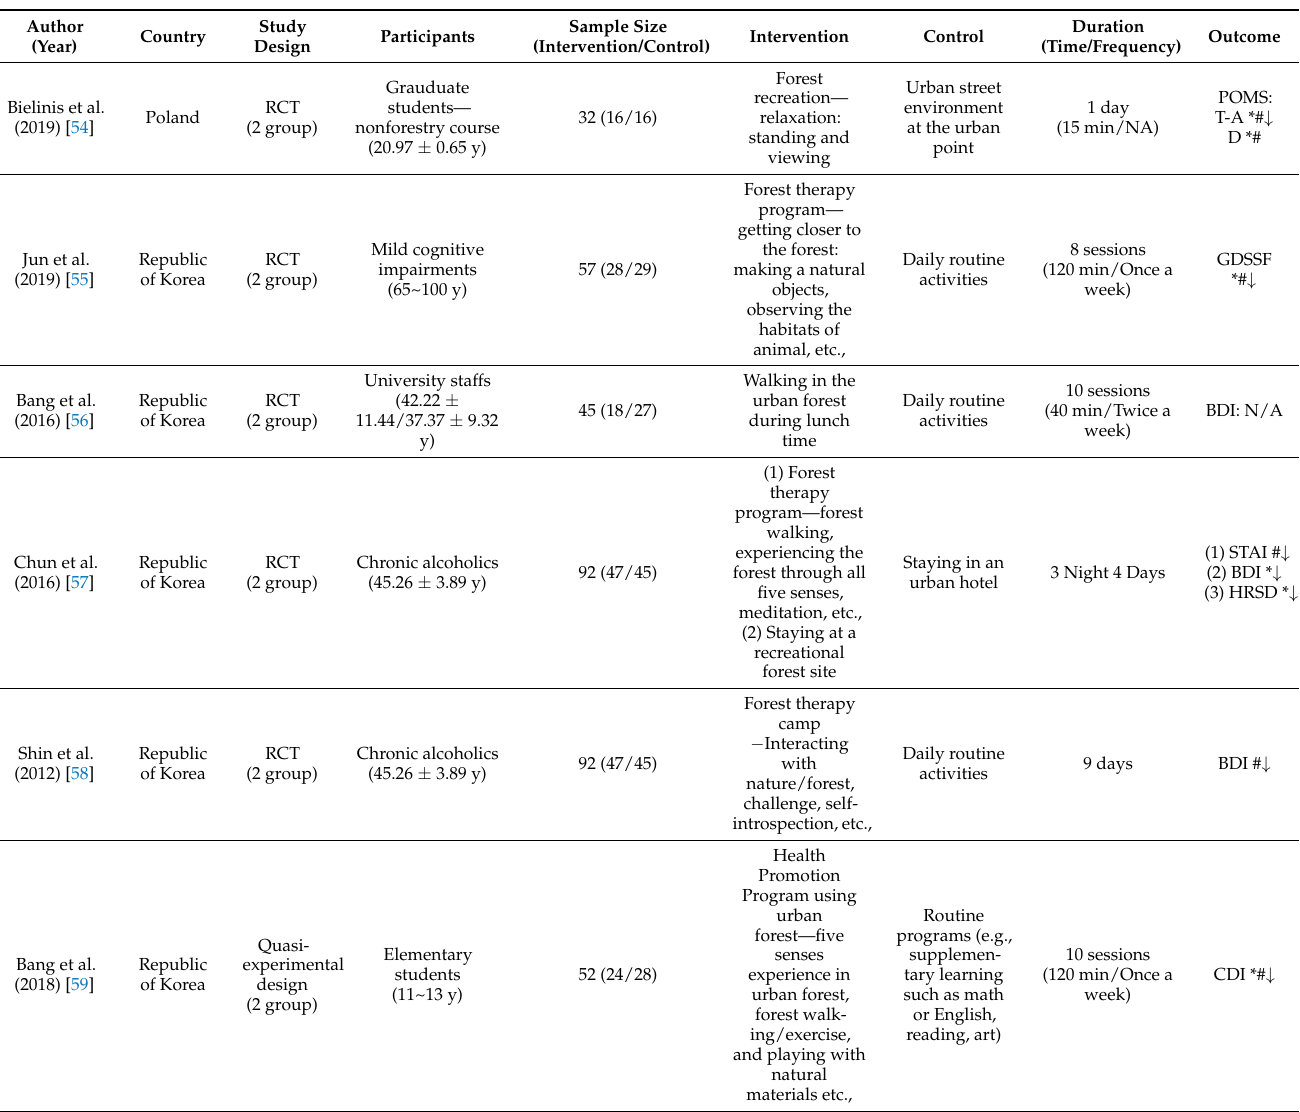
Table 2. Characteristics of the 20 included